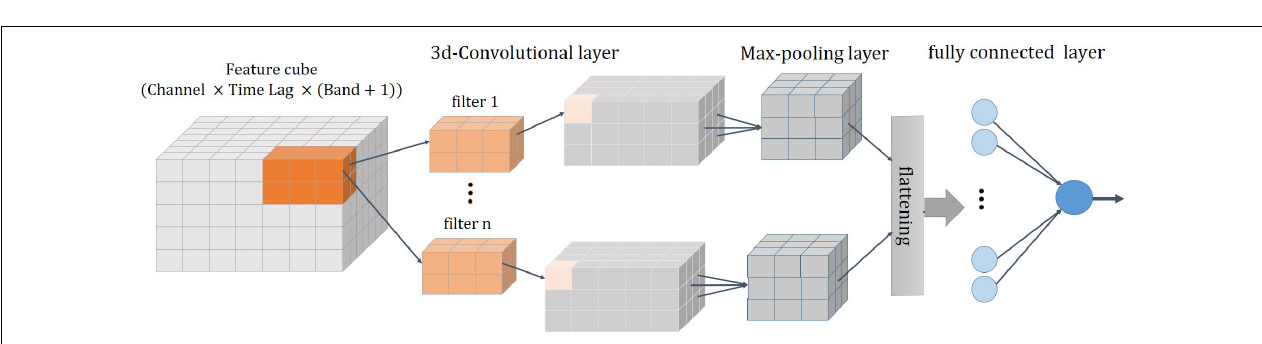
FIGURE 6 | A schematic of 3D-CNN. It consists of four layers: a 3D convolutional layer, followed by a max-pooling layer, a flattering layer, and a fully connected layer.